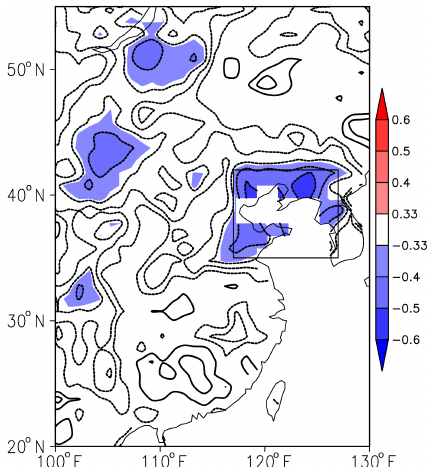
Figure 10. The CC between WHD NCP DY and soil moisture DY in autumn from 1980 to 2013. The shades indicate that the CC ex- ceeded the 95% confidence level, and the rectangle represents the selected region (35–42 ◦ N, 117–127 ◦ E) of predictor x 5